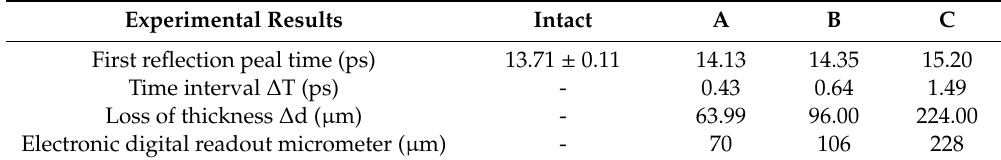
Table 1. Loss of thickness ( ∆ d) calculated from time delay ( ∆ T) spot positions A, B, C compared to digital micrometer measurements [50].